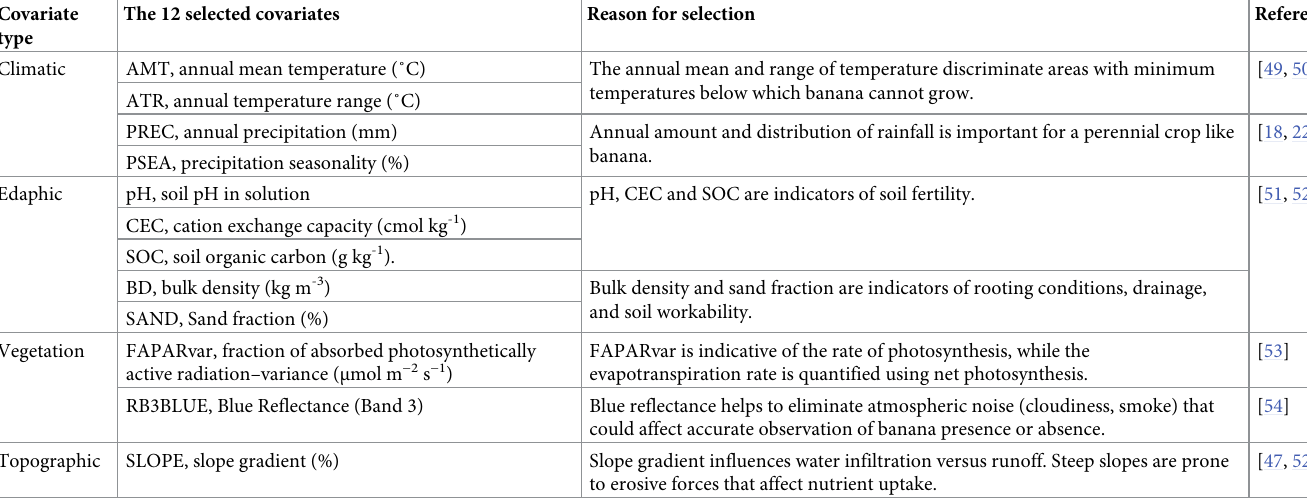
We extracted values from the 12 and 17 independent covariates at the filtered presence/ absence locations using the function extract of the package caret [55]. All missing values were omitted since most tree and rule-based models only consider complete information. The resul- tant datasets were partitioned into training (67%) and testing (33%) using the createDataParti- tion function of the package caret [55]. Table 2. List of 12 covariates selected subjectively and their underlying reasons for their selection. Covariate The 12 selected covariates Reason for selection type The annual mean and range of temperature discriminate areas with minimum temperatures below which banana cannot grow. Annual amount and distribution of rainfall is important for a perennial crop like banana. pH, CEC and SOC are indicators of soil fertility.